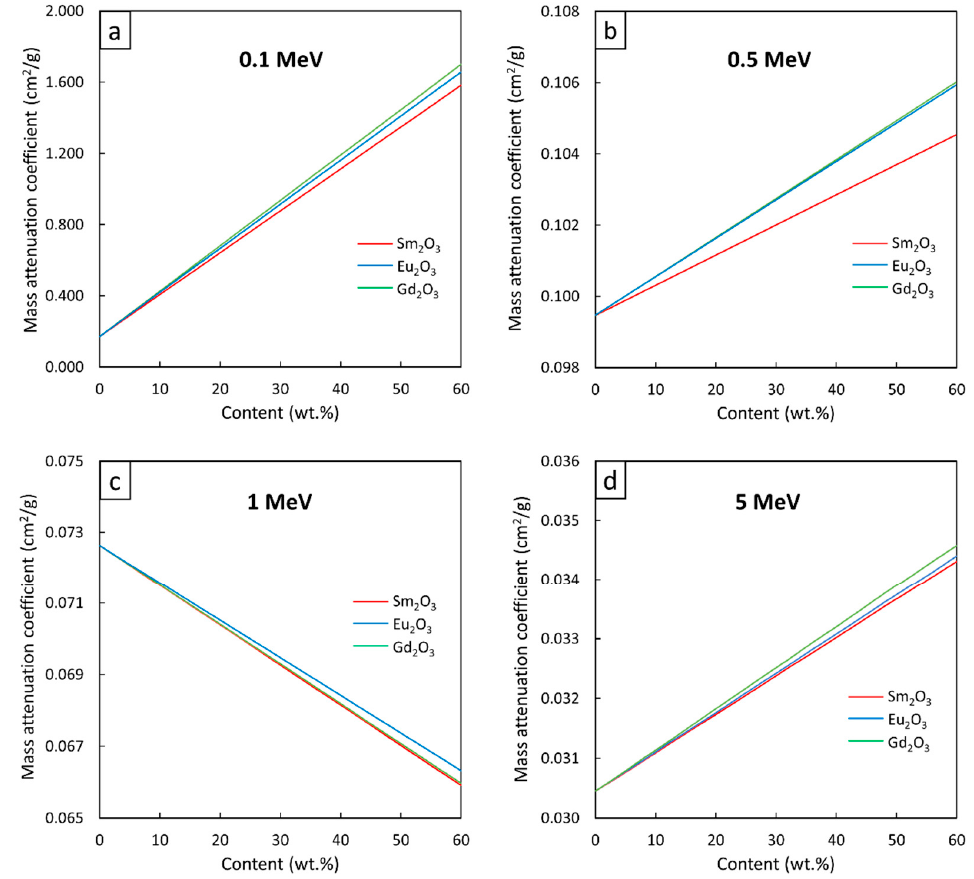
Figure 3. μ m values of Sm 2 O 3 /HDPE, Eu 2 O 3 /HDPE, and Gd 2 O 3 /HDPE composites with filler contents varied from 0–60 wt.%, determined at photon energies of ( a ) 0.1 MeV, ( b ) 0.5 MeV, ( c ) 1 MeV, and ( d ) 5 MeV using XCOM. Table 2. Mathematical coefficients (A and B) for µ m in form µ m = Ax + B (Equation (1)) from Figure 3. Photon Energy